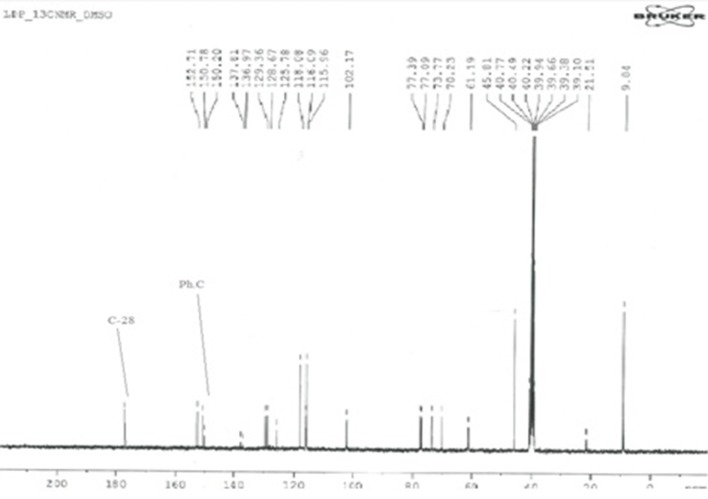
13C-NMR Spectrum of diphenyl tin complex.